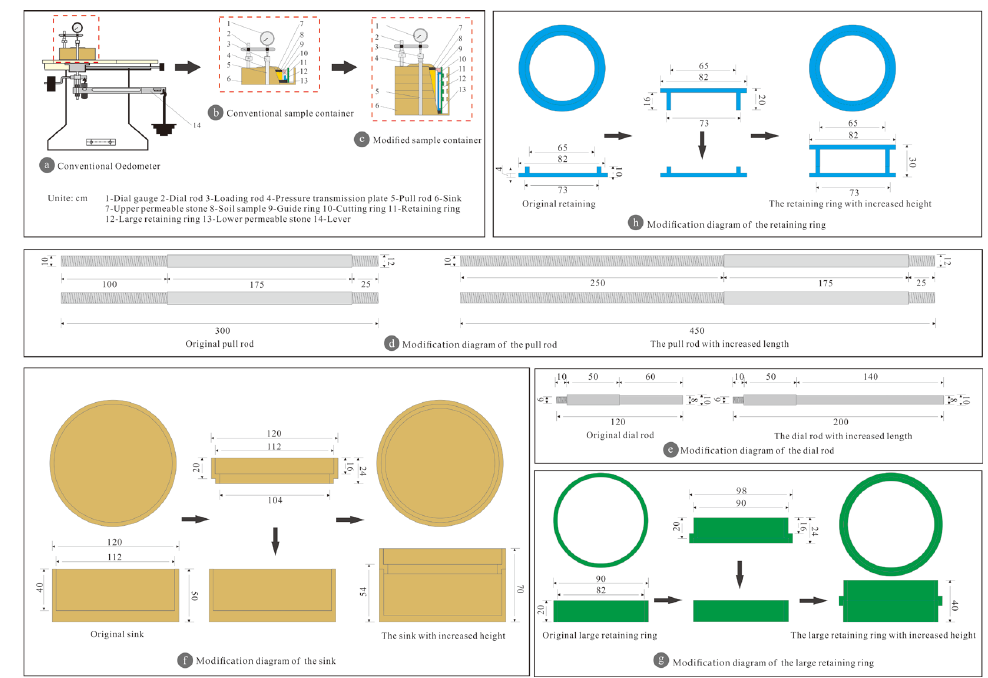
Figure 3. Schematic diagram of oedometer modification.